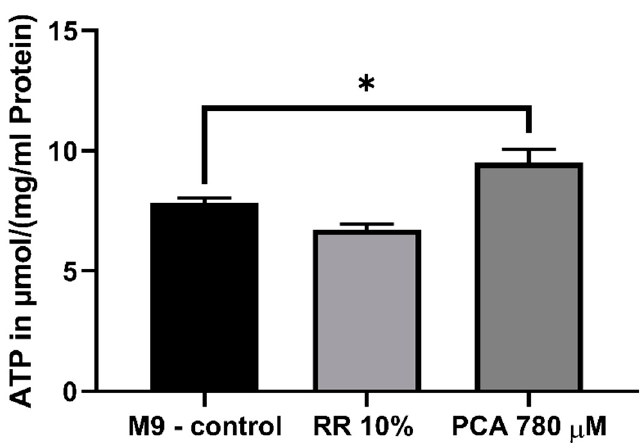
Figure 6. Determination of intracellular ATP levels in wild-type C. elegans . Animals were shock frozen and boiled for de-proteinization prior to cell lysation via sonification. ATP levels were assessed using ATPlite luminescence assay (Perkin Elmer, Waltham, MA, USA) and values normalized to protein concentrations. PCA increased levels significantly. n = 8; mean ± SEM; one-way ANOVA with Tukey´s multiple comparison posttest; * p < 0.05.